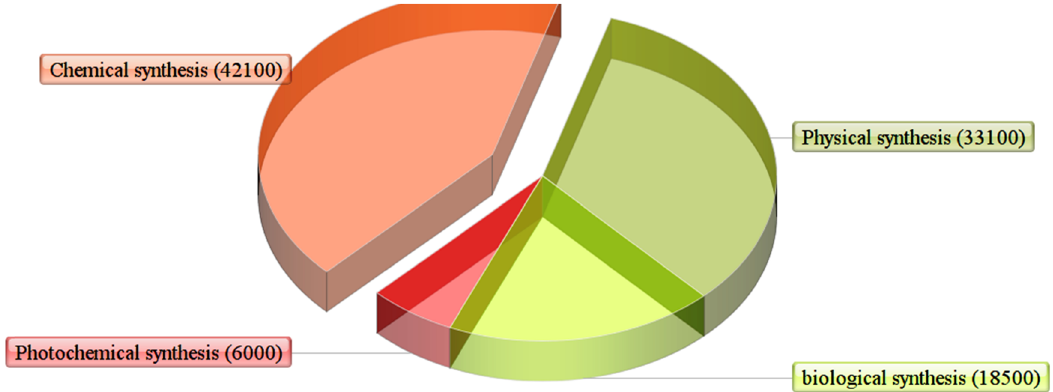
Figure 2: The published research articles on the topic of synthesis of AgNPs. The databases were collected from “ Scopus ” using the keyword “ AgNPs, ” up to 30 May,